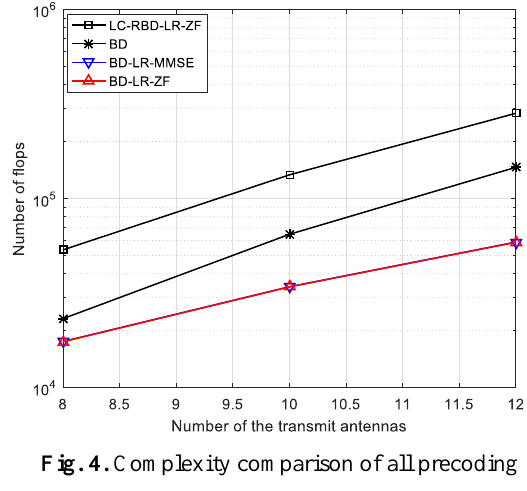
Fig. 4. Complexity comparison of all precoding algorithms